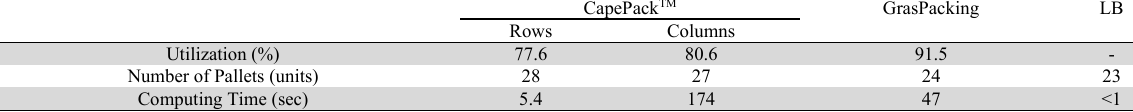
Results for real instances – Palletizing